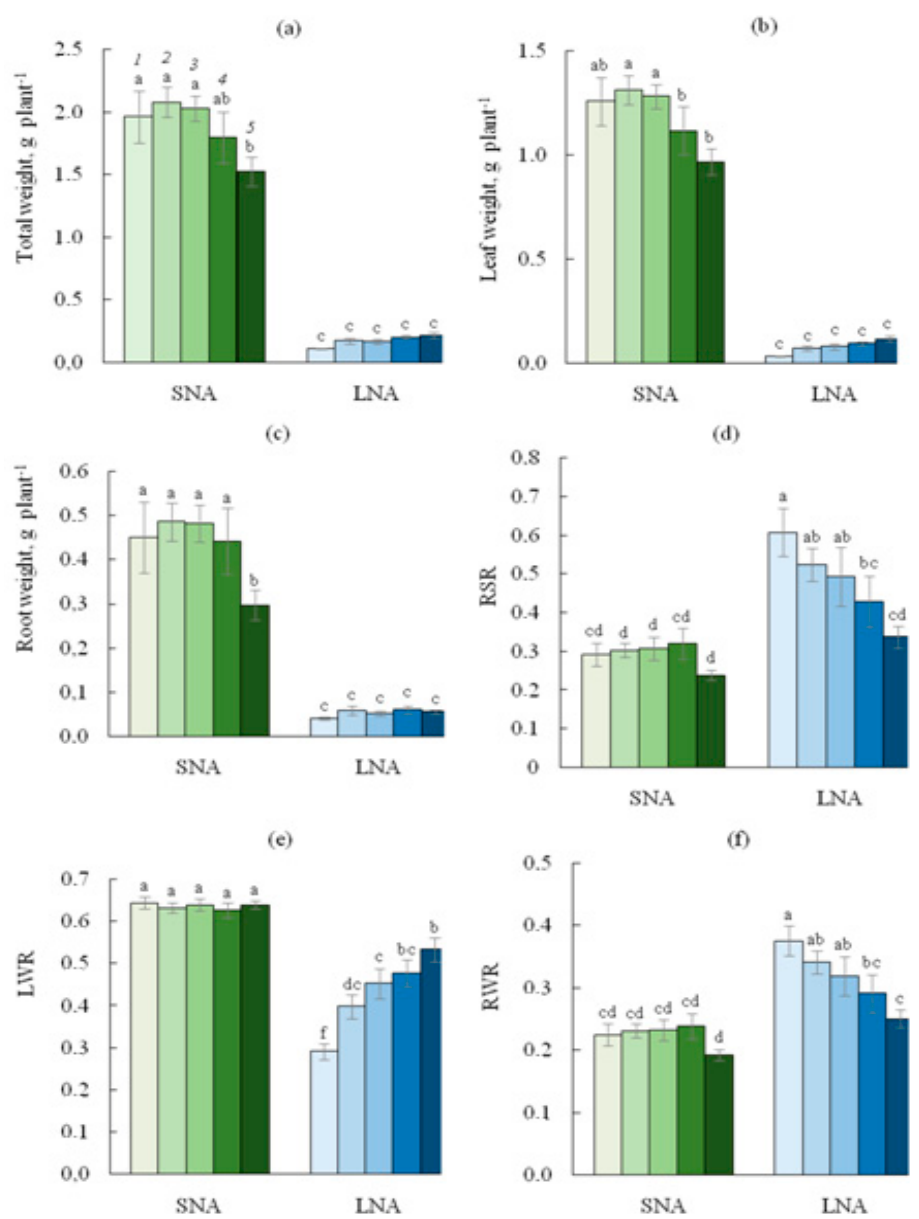
Figure 1. Total ( a ), leaf ( b ), root ( c ) weight, root shoot ratio (RSR, ( d )), leaf weight ratio (LWR, ( e )), root weight ratio (RWR, ( f )), for cucumber seedlings grown on the sandy loam soil with a sodium lignosulfonate concentration of 0 ( 1 ), 1 ( 2 ), 2.5 ( 3 ), 5 ( 4 ), and 10 ( 5 ) vol % under sufficient nutrient availability (SNA) or low nutrient availability (LNA). Significant differences at p < 0.05 indicated with different